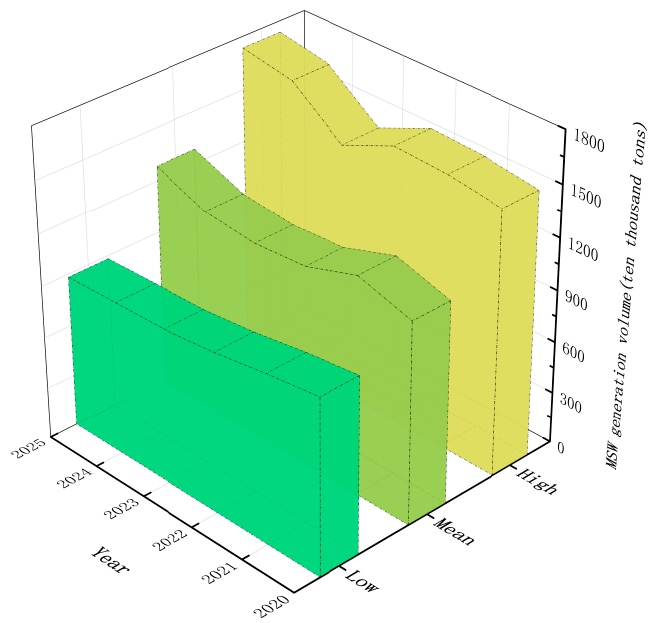
Figure 4. Scenario prediction of MSW generation in Shanghai.